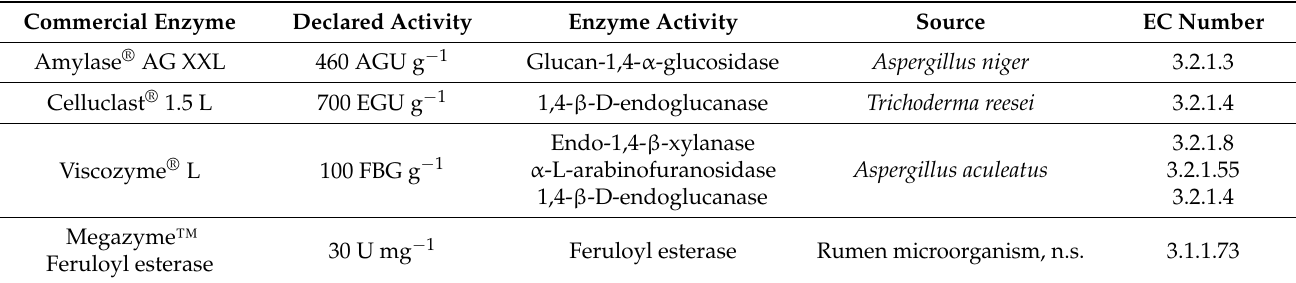
Table 2. The list of commercial hydrolytic enzymes used in this